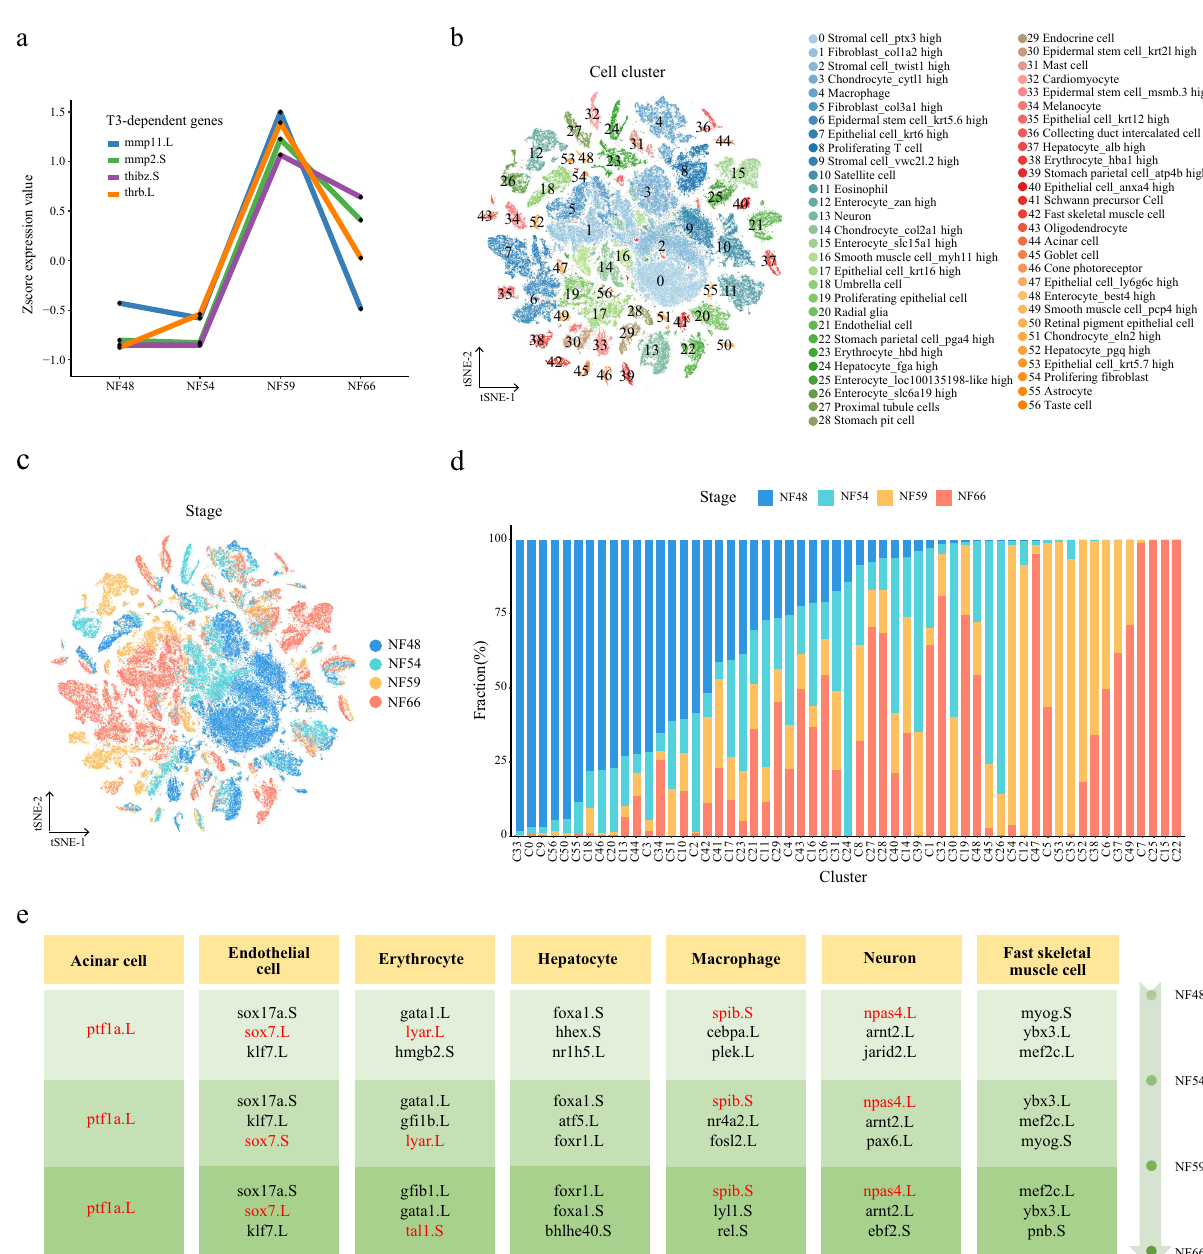
and C4 with the most proportion of NF54 and NF59 data